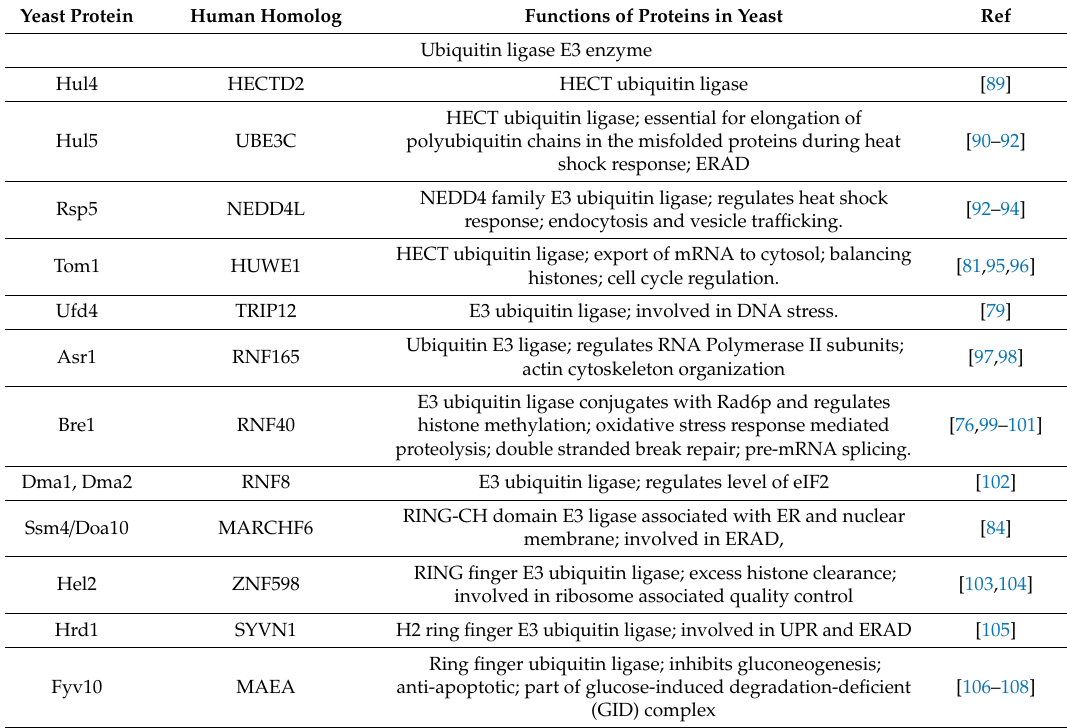
Table 3. Yeast ubiquitin E3 ligating enzymes conserved in